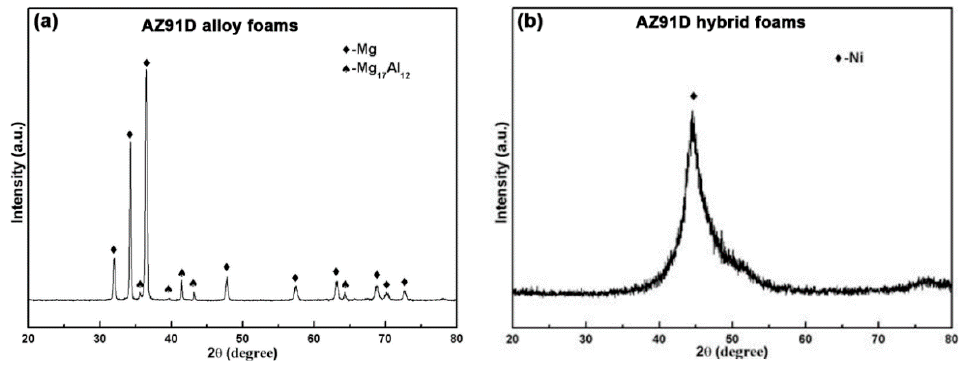
Figure 6. XRD patterns of ( a ) the AZ91D alloy foams and ( b ) the AZ91D hybrid foams.